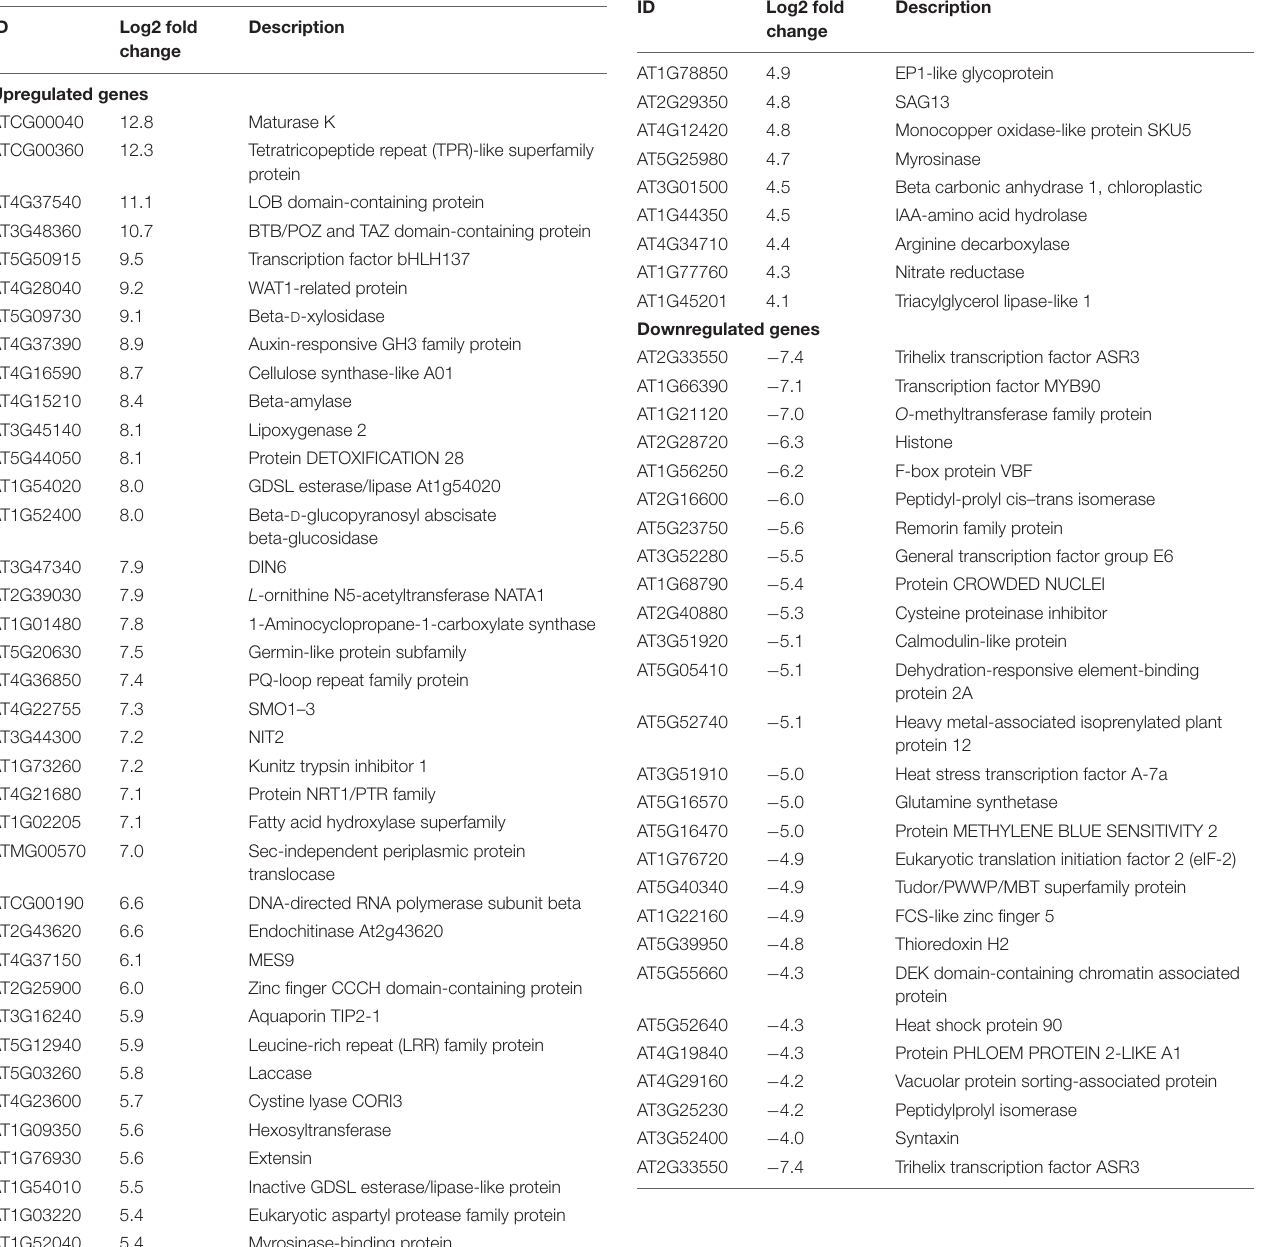
TABLE 2 | Most important differentially expressed genes in Arabidopsis plants inoculated with B. altitudinis